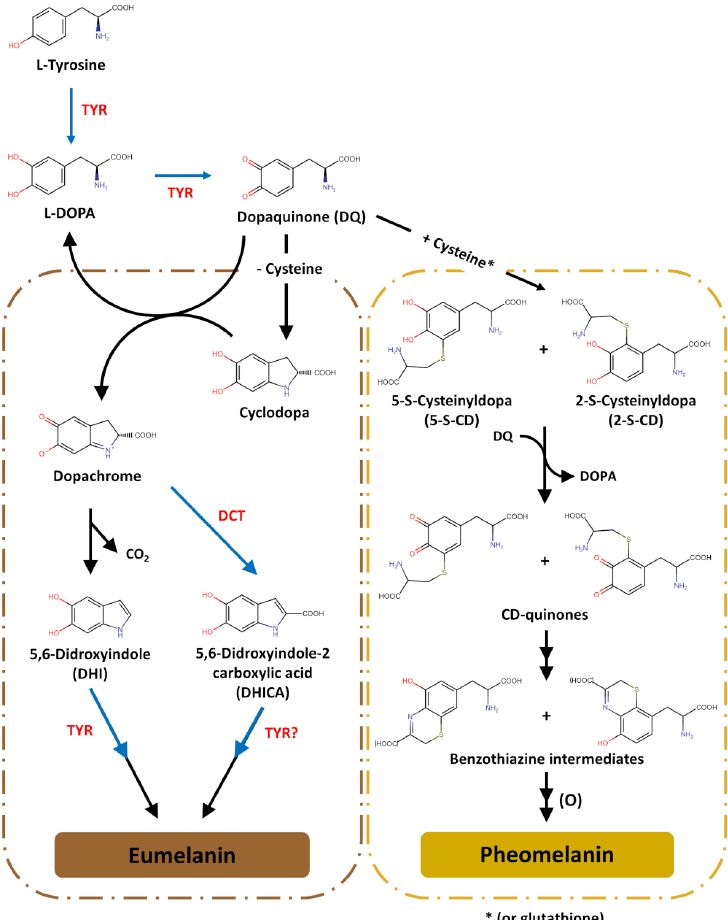
Figure 5. Biosynthetic pathways involved in the production of eumelanin and pheomelanin in human melanosomes. In these organelles, melanogenesis begins with the synthesis L-DOPA from L-Tyr and subsequent oxidation to DQ. The hydroxylation of L-Tyr to L-DOPA is catalysed by the multi-functional enzyme TYR. From here, mixed melanogenesis proceeds, using the same precursor (DQ) for the synthesis of pheomelanin and eumelanin. Pheomelanin is spontaneously produced from DQ if cysteine is present at concentrations above 1 µ M. The first step is the reductive addition of cysteine to DQ, giving rise to CD isomers 5-S-CD and 2-S-CD, at a ratio of 5 to 1. The second step is the redox exchange between CD isomers and DQ to produce CD-quinones (and DOPA), followed by their cyclization through dehydration to form ortho-quinonimine (QI). The last step involves the polymer- ization of benzothiazine intermediates to pheomelanin. The production of pheomelanin is preferred over the production of eumelanin in the presence of CD isomers at concentrations above 10 µ M. The production of eumelanin begins after most CD isomers and cysteine are depleted. DQ undergoes spontaneous intramolecular cyclization to give rise to cyclodopa. Then, cyclodopa rapidly undergoes redox exchange with another DQ molecule to produce one molecule of dopachrome, a relatively stable intermediate, and one molecule of DOPA. In the absence of additional factors, dopachrome undergoes spontaneous decarboxylative rearrangements to form 5,6-dihydroxyindole (DHI). In the presence of DCT, the tautomerization of dopachrome can also form 5,6-dihydroxyindole-2-carboxylic acid (DHICA). However, human bulbar melanocytes (at least those of eumelanic phenotypes) do not express this protein, and human hairs contain low yields of DHICA. Both dihydroxyindoles (DHI and DHICA) are further oxidized and assembled via cross-linking reactions into eumelanin polymers. Oxidative polymerization of DHI is catalysed directly by tyrosinase and indirectly by DQ. Spontaneous reactions are denoted as black arrows. Enzyme-catalysed reactions are signalized by blue arrows. CD: cysteinyldopa; L-DOPA: L-3,4-dihydroxyphenylalanine; TYR: tyrosinase; DCT: dopachrome